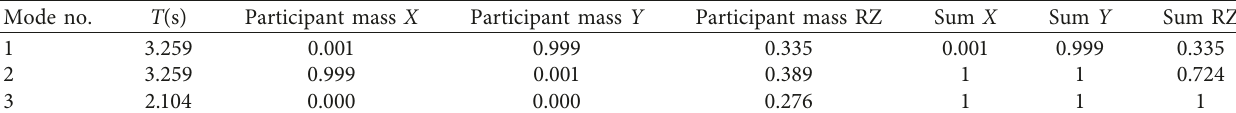
Table 2: Four-column frame: periods and participant masses (translation X , translation Y , and rotation Z in the vibration modes). Mode